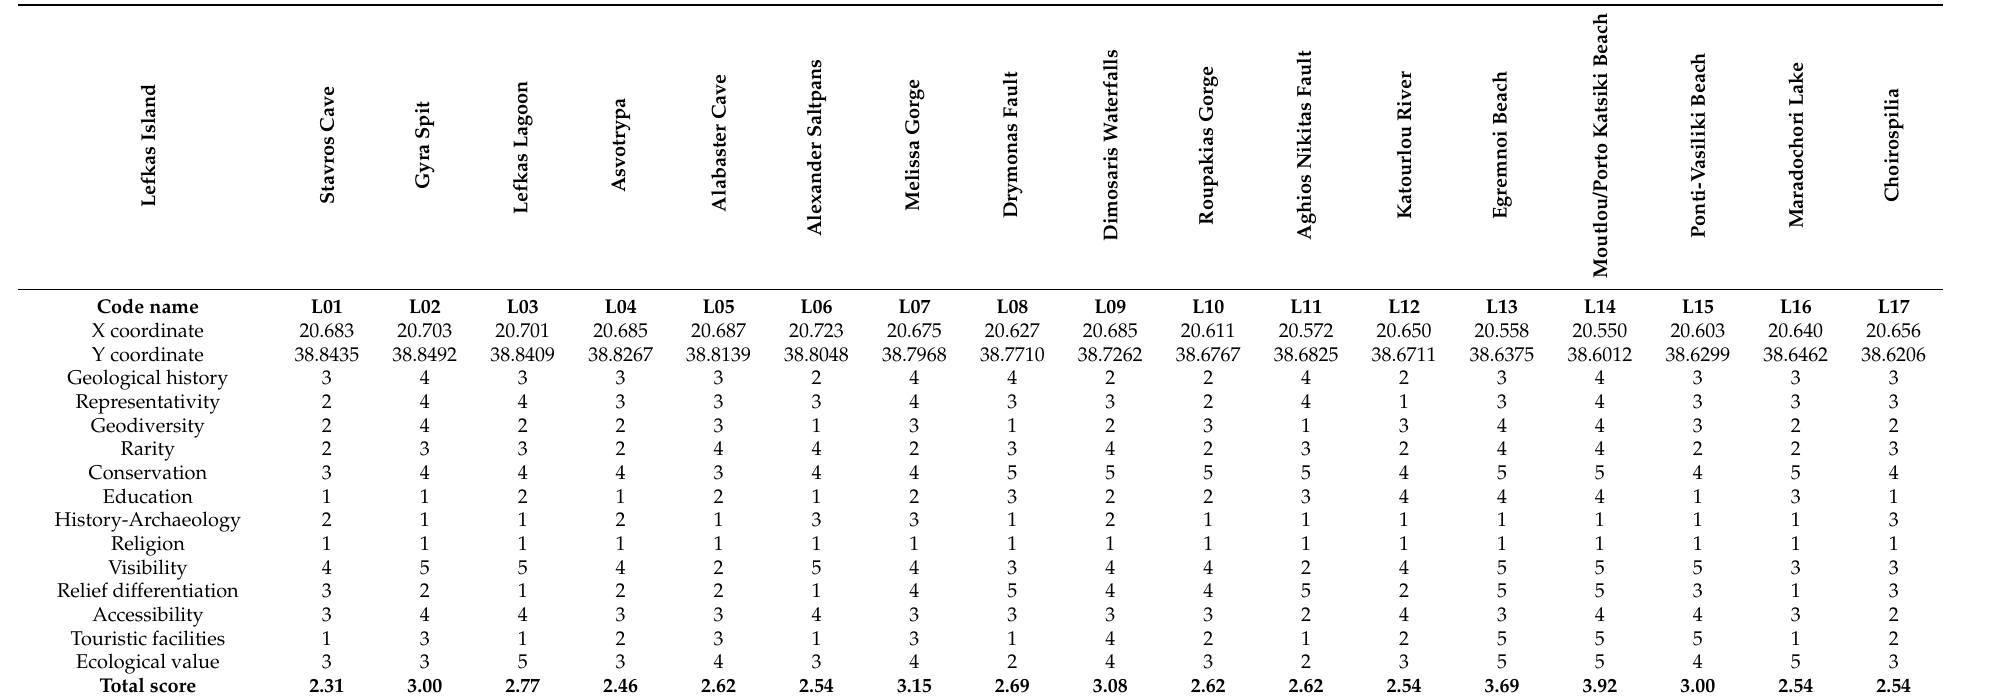
Table 2. Lefkas island geosites assessment, following the evaluation criteria of Table